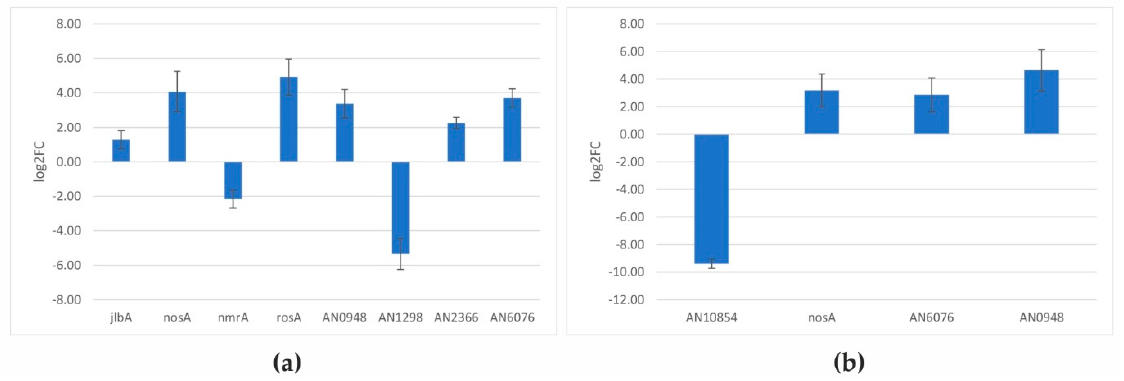
Figure 2. Quantitative transcriptional analysis of selected genes differentially expressed in ( a ) kae19 and ( b ) kaeA25 mutant strains. Relative expression in kaeA mutants in comparison with control isogenic wild-type strain was calculated by RT-qPCR analysis. FC, fold change in keaA19(25)